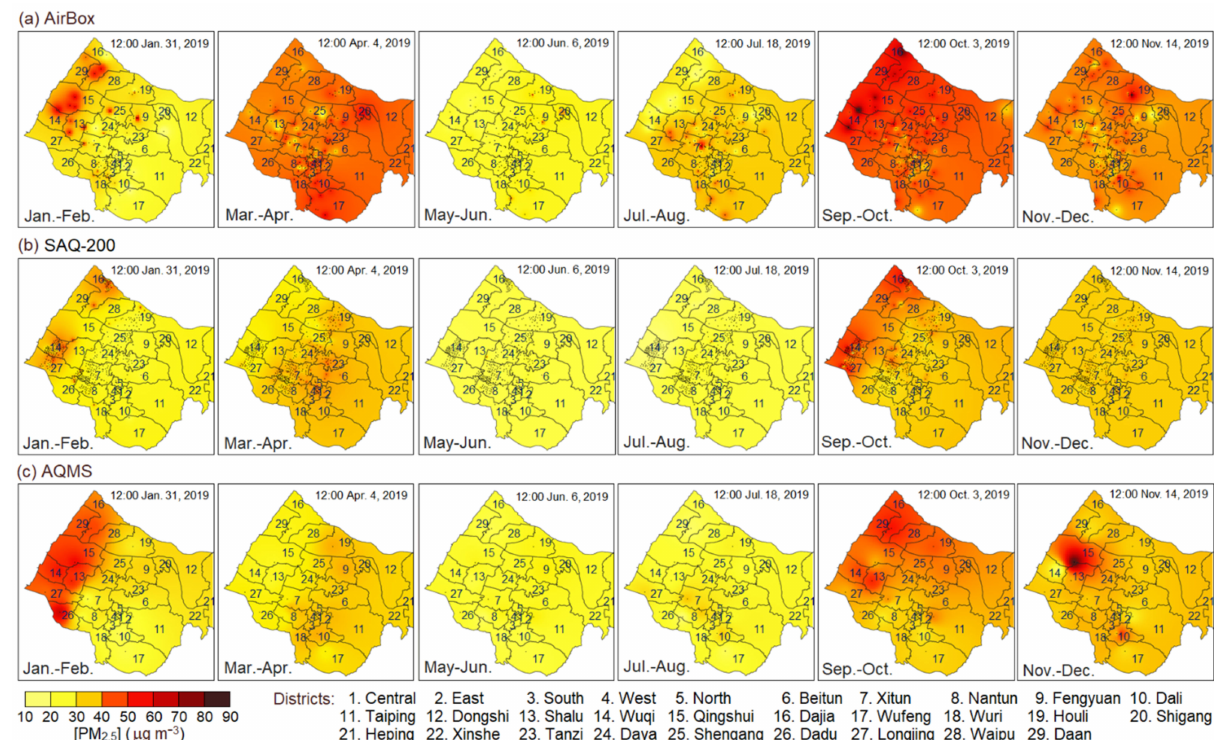
Figure 8. Bi-monthly PM 2.5 spatial distributions based on the spatial interpolation results of the observed data from the two low-cost sensor systems and air quality monitoring systems (AQMS)